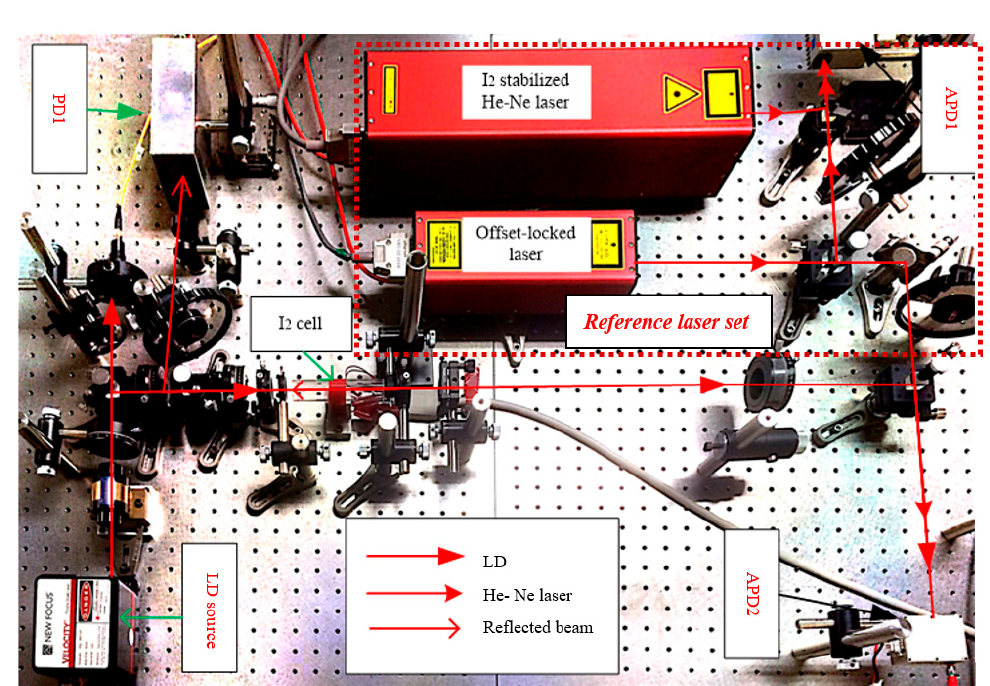
Figure 3. Experimental setup of the frequency-stabilized LD system. LD: laser diode; PD: photodetector; APD: avalanche photodetector.